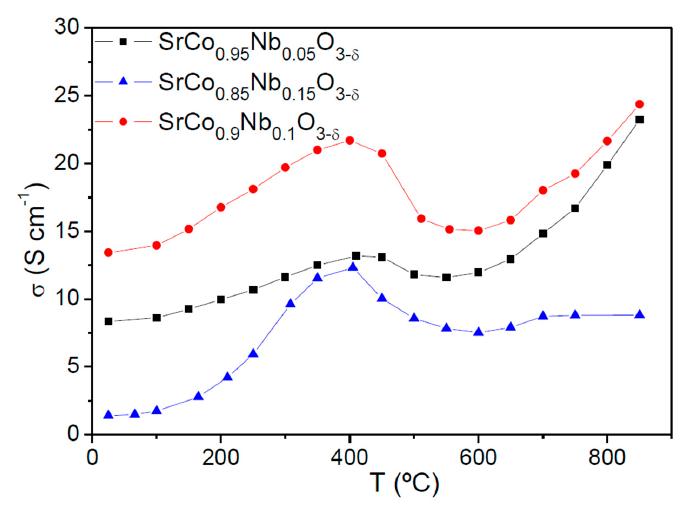
Figure 6. Dc-conductivity as a function of temperature for SrCo 1 − x Nb x O 3 − δ ( x = 0.05, 0.10, 0.15). Data for x = 0.05 are taken from ref. [18], reprinted and adapted from [18], with permission from © 2014 Elsevier.